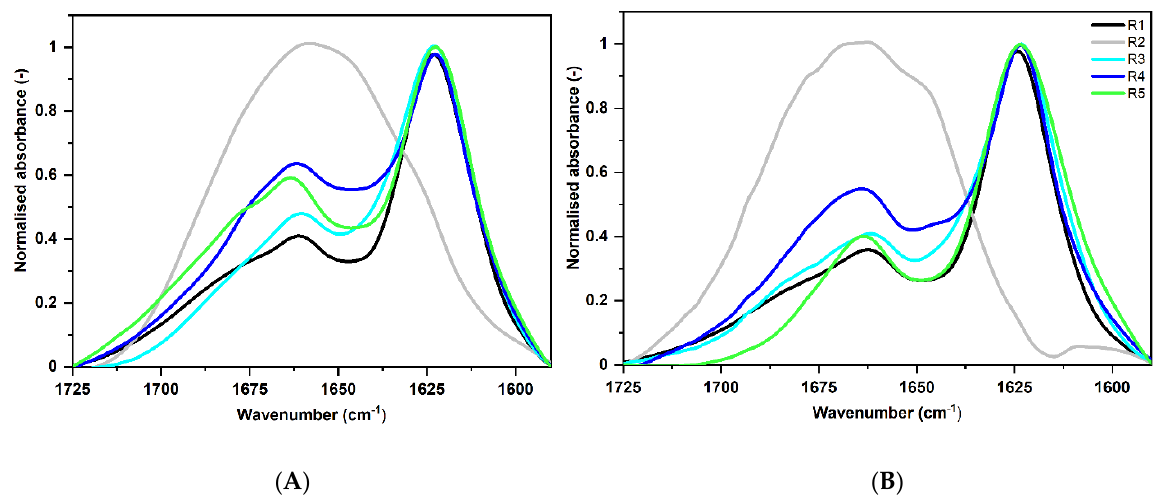
Figure 4. Normalized ATR-FTIR spectra of S. enterica fragments in the wavenumber range of 1725–1590 cm −1 (Amide I), smoothed with SG 35 (see Methods). ( A ) on the day of the dissolving ( B ) after month incubation at 37 °C. Peptide concentration was 500 µM.